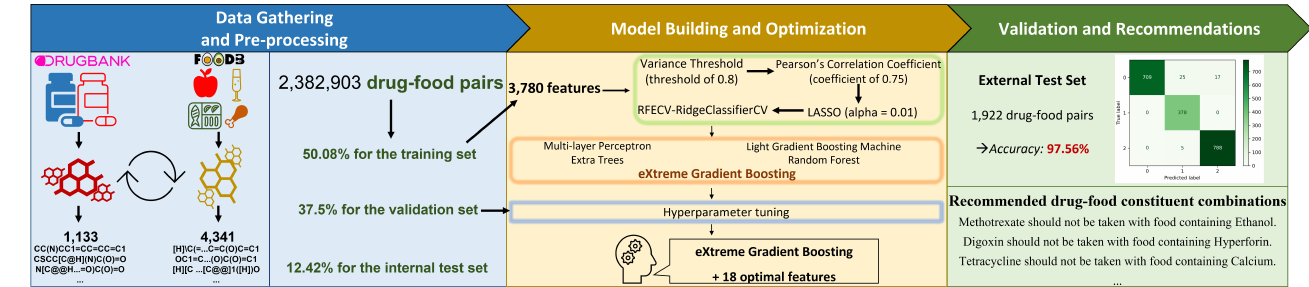
Figure 1. The workflow of our study. First, we obtained the SMILES notations of drug and food constituents from DrugBank and FooDB databases. After pre-processing, we filtered out 1133 drugs and 4341 food compounds, making 2,382,903 drug–food pairs in the benchmark dataset. We subsequently used PyBioMed and RDKit packages in Python to extract 3780 features of each interacting drug–food pair. We applied a four-step feature selection process to the training set to find the 18 most important features. Five classification algorithms were applied to the training data via five-fold cross-validation. As XGBoost gave the best prediction outcome, we fine-tuned it using the validation set. Finally, we tested our optimum XGBoost model on the internal test set and one external test set containing 1922 drug-food pairs. Finally, we used the model to recommend some common drug–food compound